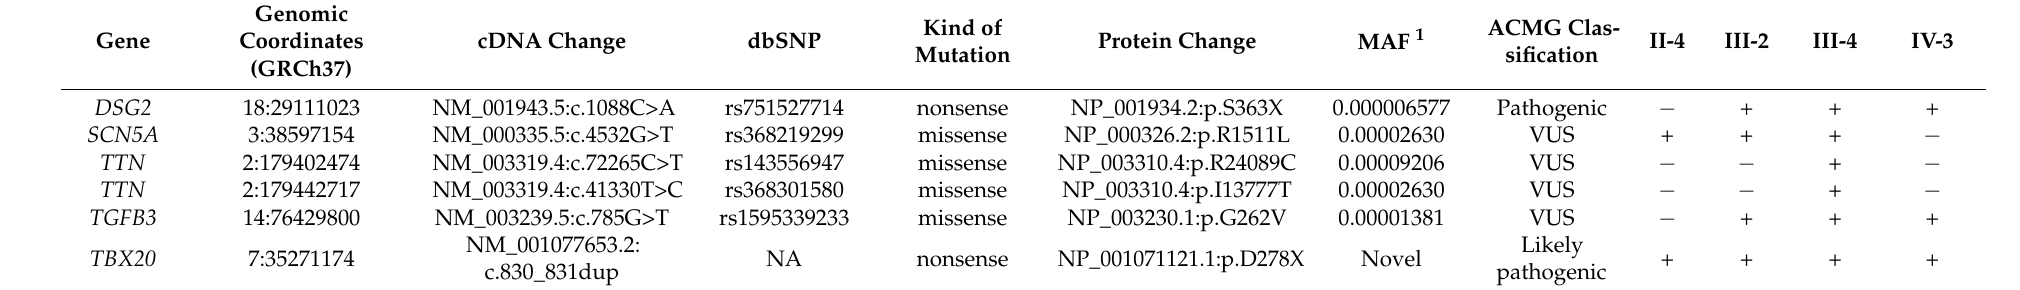
Table 3. List of rare variants (MAF < 0.001) identified in the